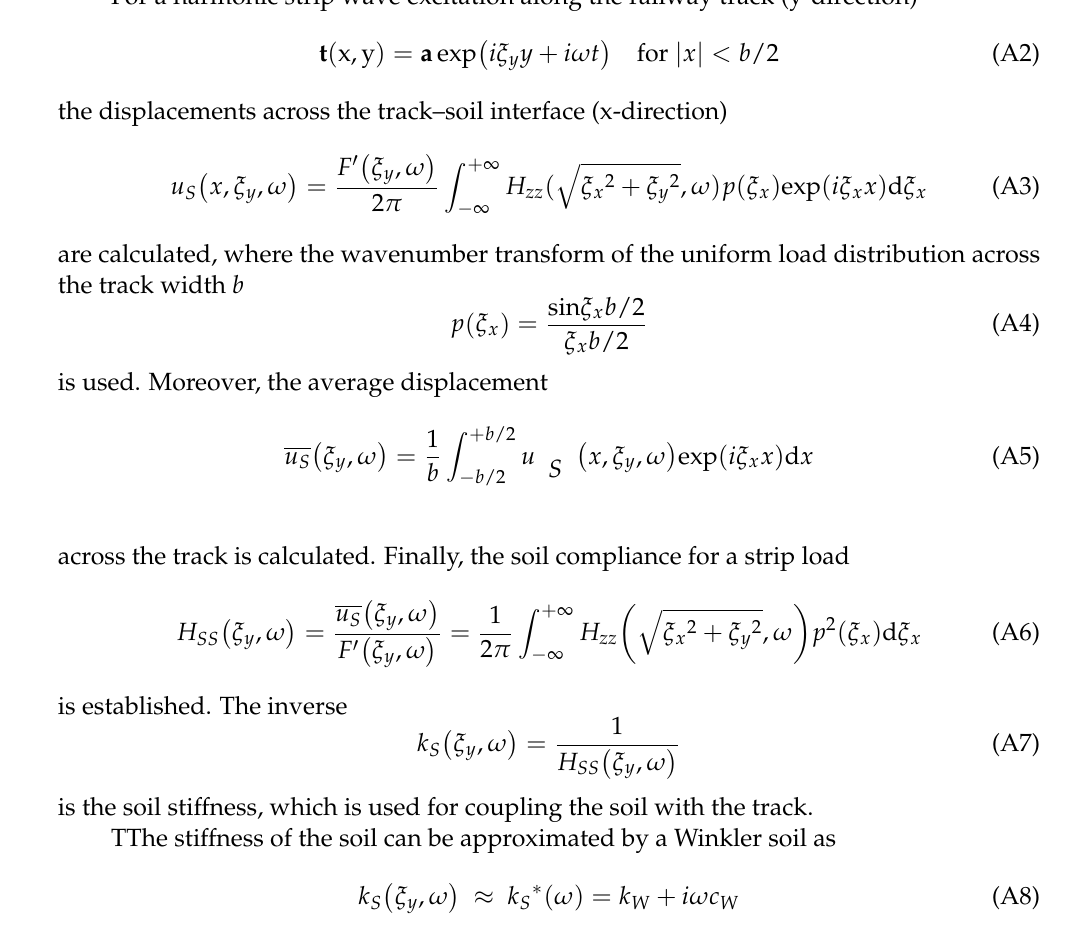
Figure A1. Transfer function of a soil with v S 1 = 125 m/s, v S 2 = 350 m/s, h = 4 m, D = 2.5% at distances x = □ 4, ○ 8, ∆ 16, + 32, × 64 m, ( a ) exact, ( b ) approximated solution.